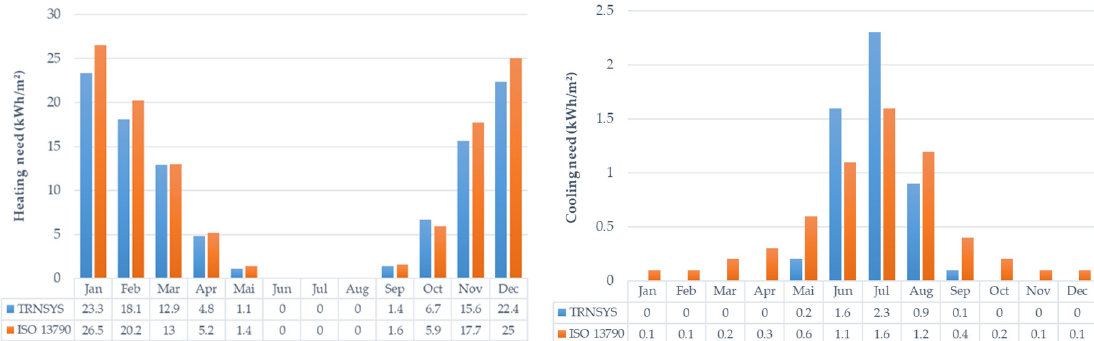
Figure 8. Comparison of energy simulation results obtained with TRNSYS and ISO-based CityBEM for an office building (1975).